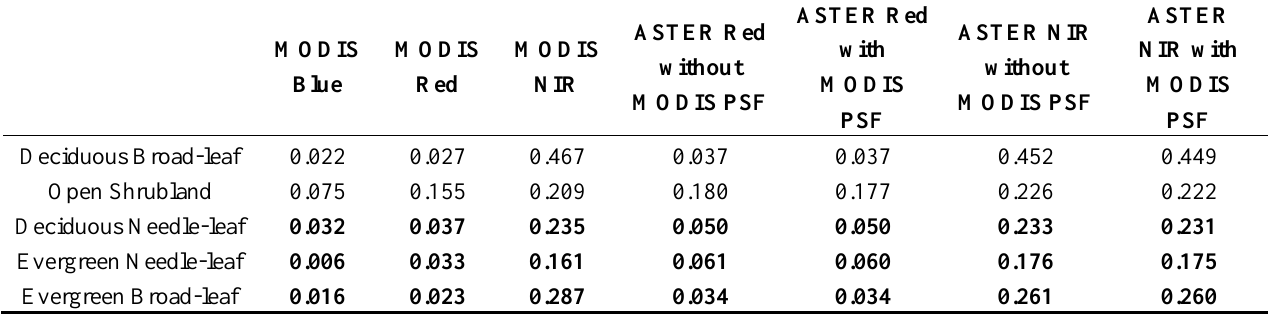
Table 3. Average of MODIS and ASTER reflectances with or without MODIS PSF for each band and each land cover